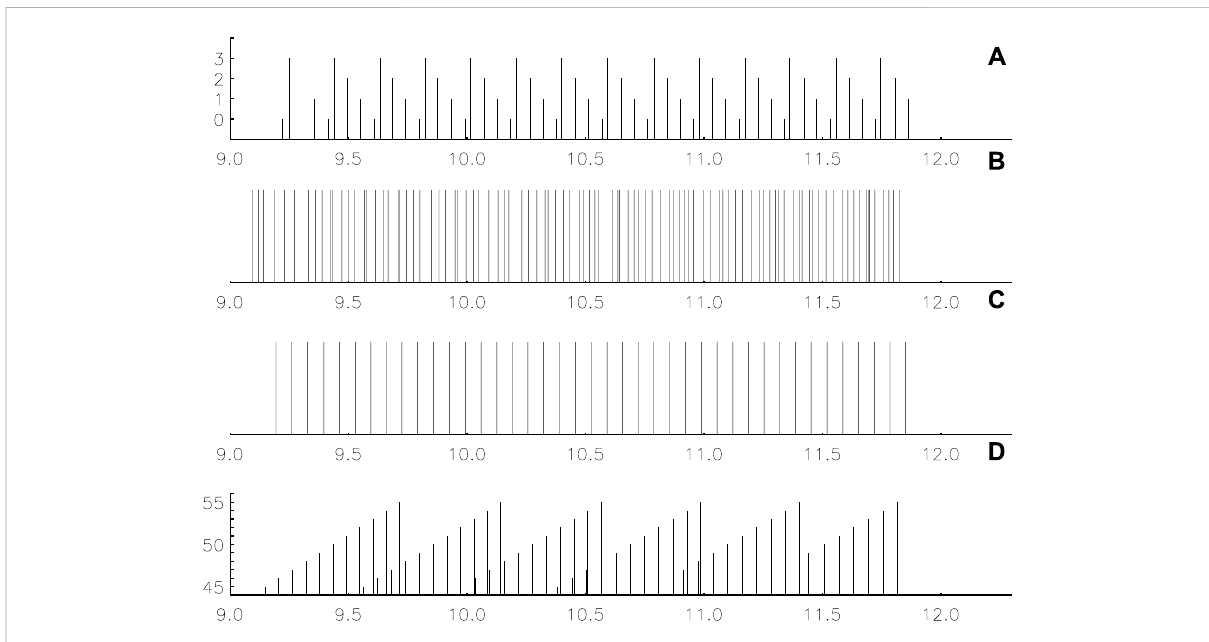
FIGURE 4 Frequency sub-spectra for the four classes of axisymmetric acoustic modes. (A) 2-period island modes, (B) chaotic modes, (C) 6-period island modes, (D) whispering gallery modes. The horizontal axis is the mode frequency in units of ω p — computed from the keplerian velocity computed using the polar radius – , and the vertical axis represents the second quantum number — the rapid rotator equivalent to the degree ℓ — when de fi ned. Figure taken from Lignières and Georgeot